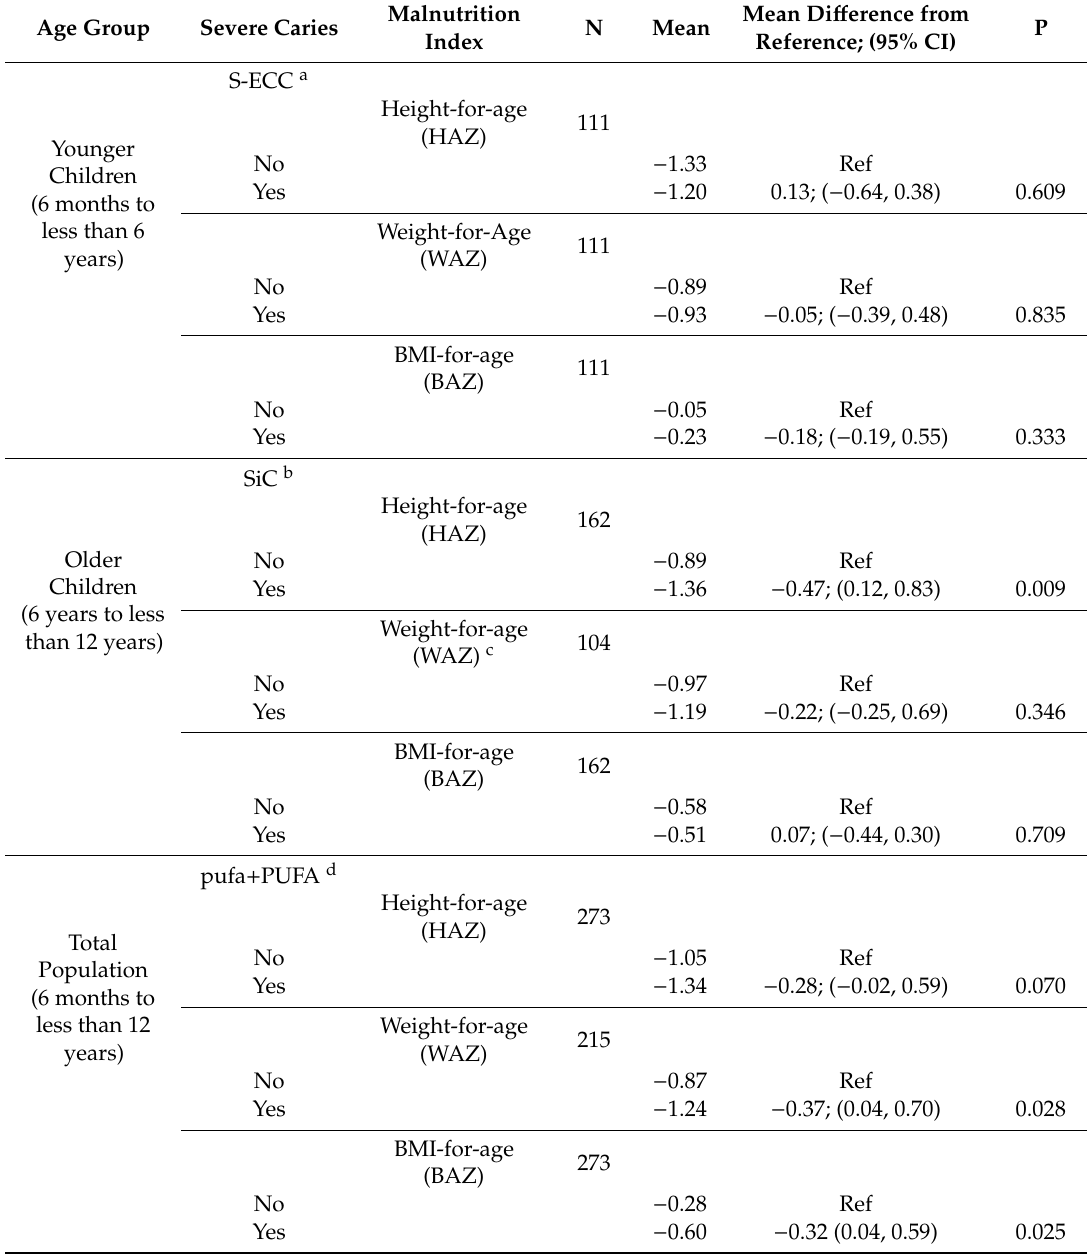
Table 4. Association between Severe Caries and Nutritional